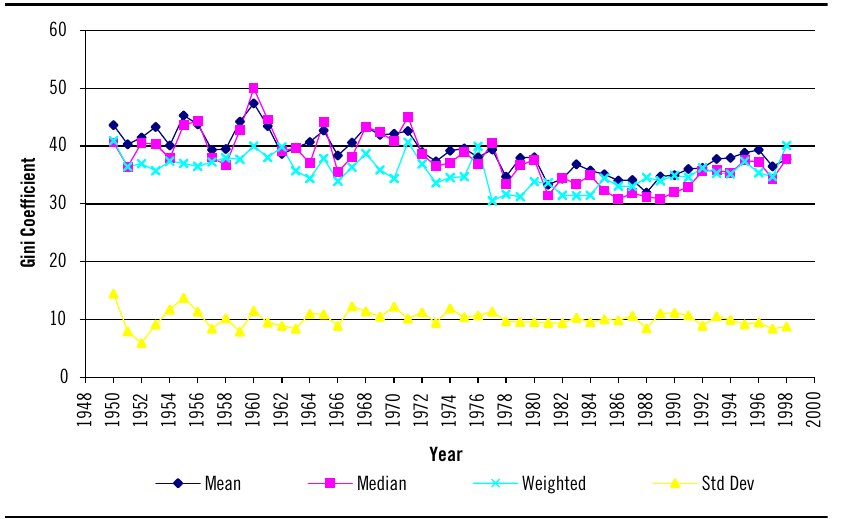
Figure 1 – Global Trends in Income Inequality